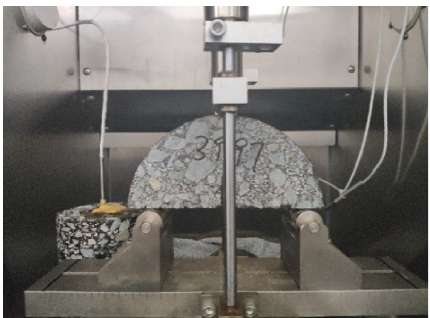
Figure 9: Photograph of the assembly of semicircular split